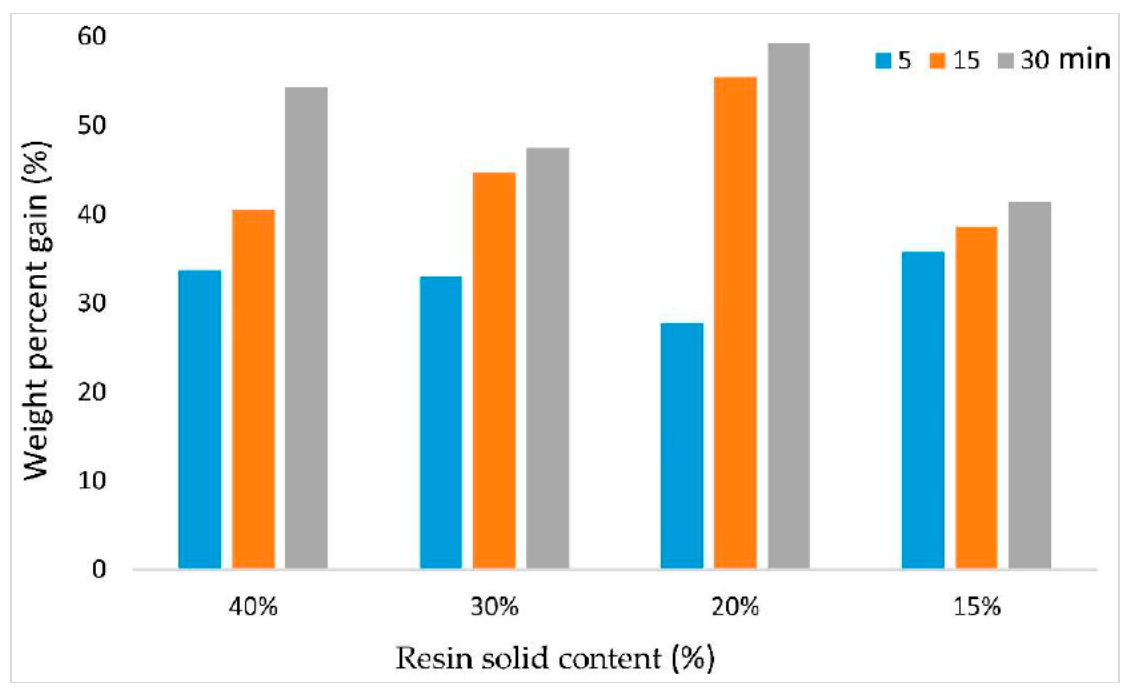
Figure 1. Weight percent gain (WPG) of OPT veneers as a function of resin solid content and soaking time.